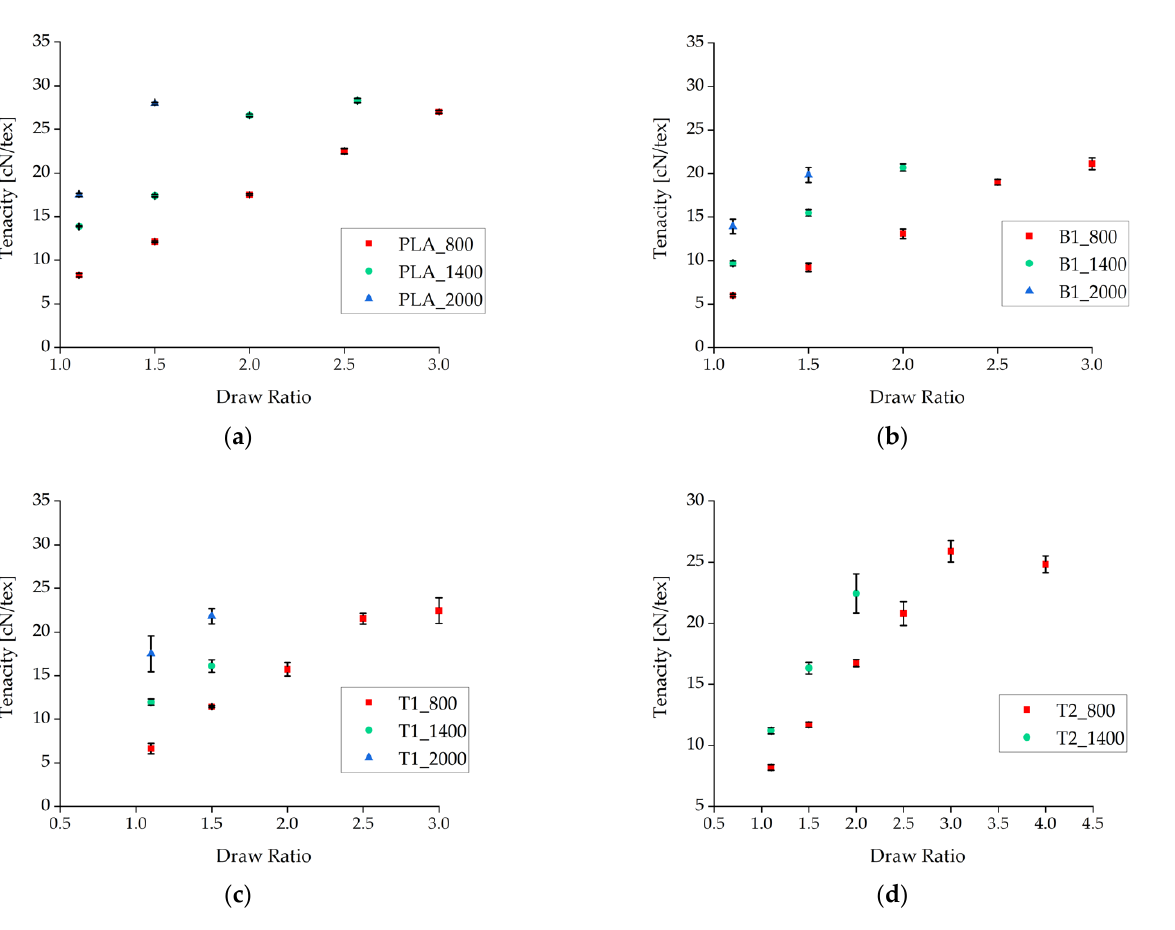
Figure 3. Tenacity of fibers plotted against the draw ratio for different nucleation agents. ( a ) Pure PLA fiber as a reference. ( b ) Fibers containing 1% ( w / w ) BHET. ( c ) Fibers containing 1% ( w / w ) talc. ( d ) Fibers containing 2% ( w / w ) talc. Data are plotted as the mean ± standard deviation (n = 5). Under comparable processing conditions with a take-up velocity of 800 m/min, pure PLA fibers showed the highest tenacity and the samples containing BHET showed the lowest tenacity (Figure 4). Increasing the take-up velocity and/or the draw ratio did not improve the tenacity of BHET-containing fibers beyond a value of 21 cN/tex. There was little difference in tenacity between samples containing 1% and 2% ( w / w ) talc, although the latter could be extended further if production was successful. Data point values and the corresponding error values are given in Table